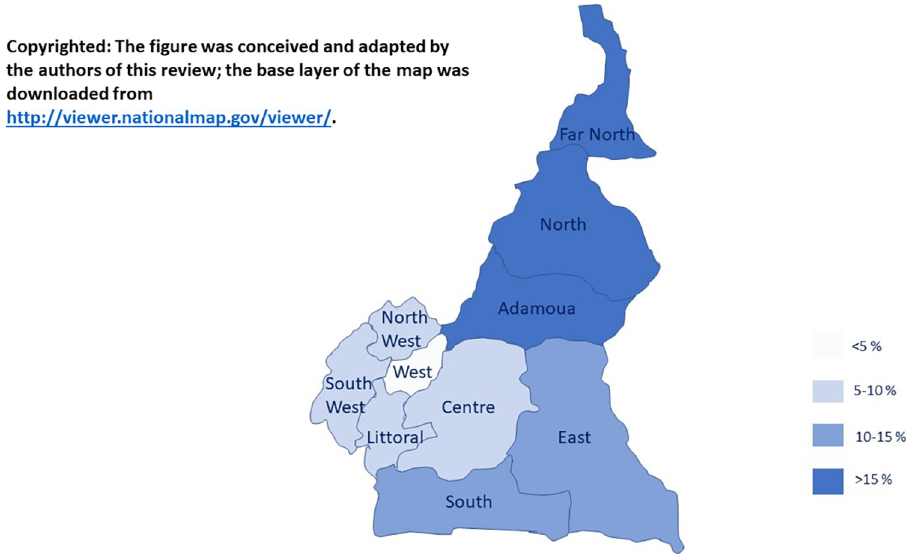
Fig 5. Pooled vertical transmission rate of HIV in Cameroon. The figure was conceived and adapted by the authors of this review; the base layer of the map was downloaded from http://viewer.nationalmap.gov/viewer/.